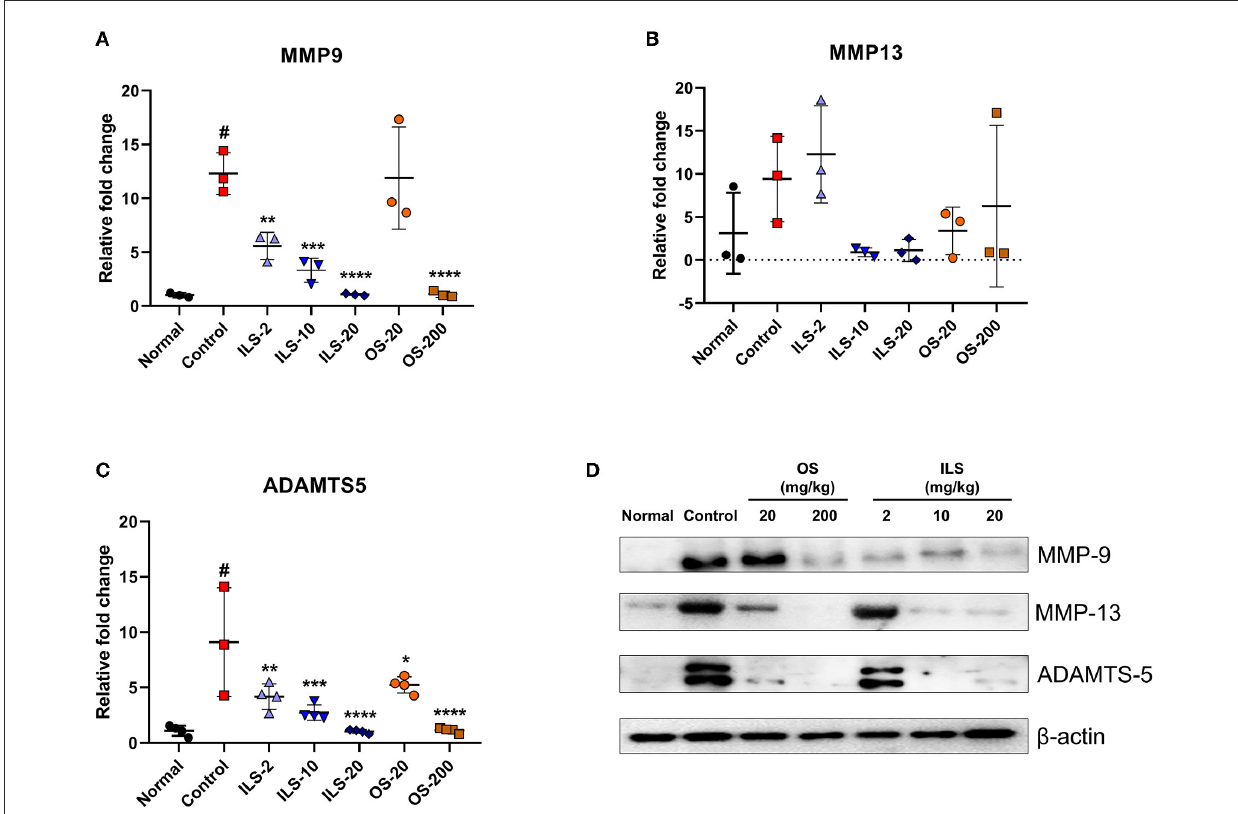
FIGURE4 Effect of Shinbaro 2 on the expression of MMP-9, MMP-13, ADAMTS-5 mRNA, and protein in LDH rats. (A–C) Gene expressions analyzed with tissue samples after Shinbaro 2 administration with two routes in LDH rats for 14 days: (A) MMP-9 , (B) MMP-13 , (C) ADAMTS-5, and (D) western blot analysis of MMP-9, MMP-13, and ADAMTS-5 protein expression at 14 days. The β -actin image is re-used for an illustrative purpose. Data are expressed as mean ± SEM. Significant differences indicated as # a p < 0.001 compared vs. the blank group, *a p < 0.05, **a p < 0.01, ***a p < 0.001, and ****a p < 0.0001 vs. the control group were analyzed via one-way ANOVA with Tukey’s post-hoc